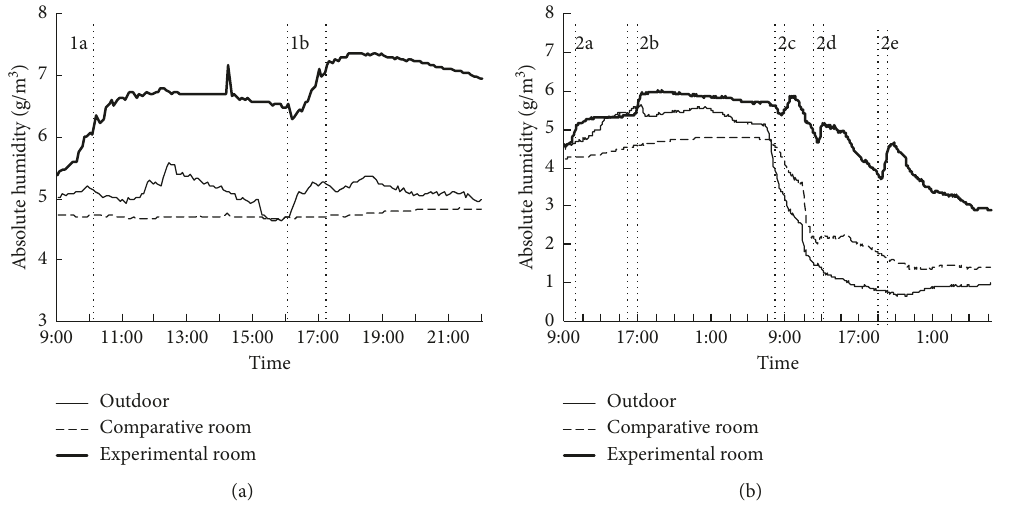
Figure 13: Absolute humidity variations: (a) Test 1 and (b) Test 2.